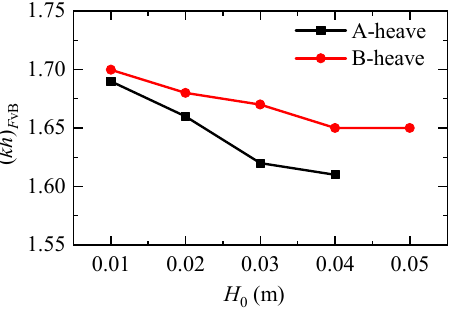
Figure 15. Variations of the frequency ( kh ) Fv B with the incident wave